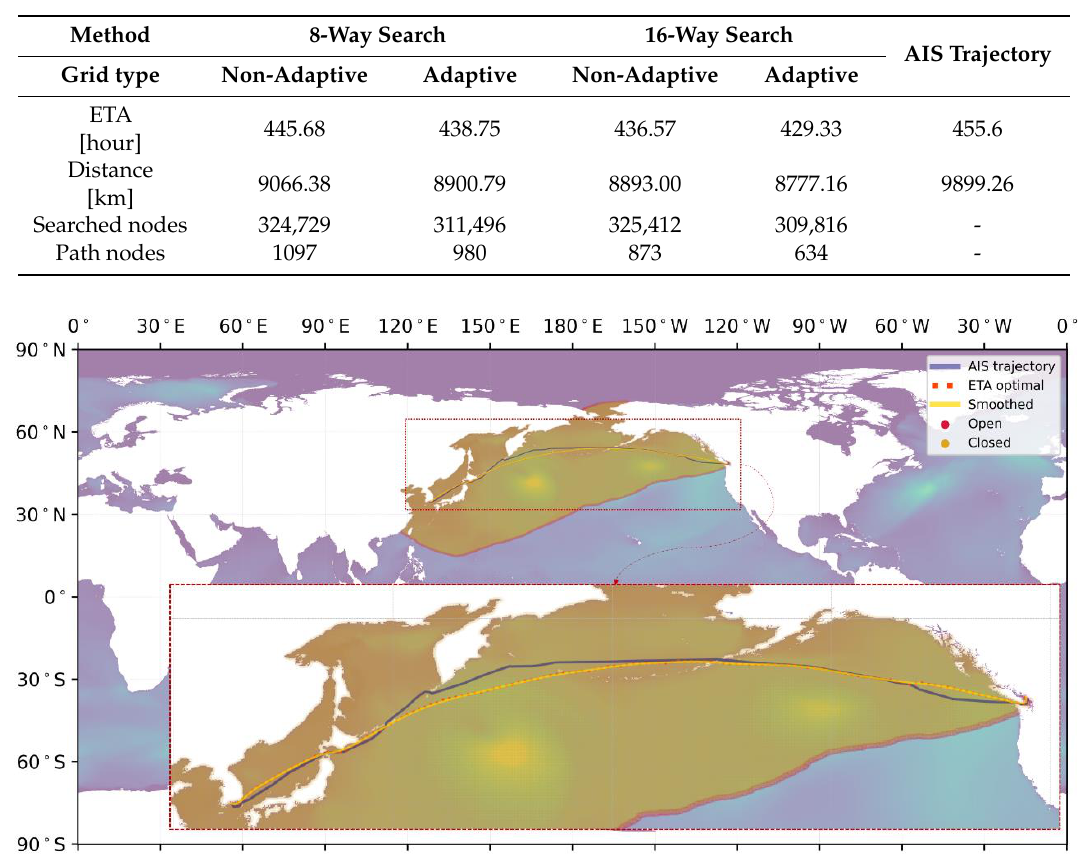
Table 11. Simulation results.